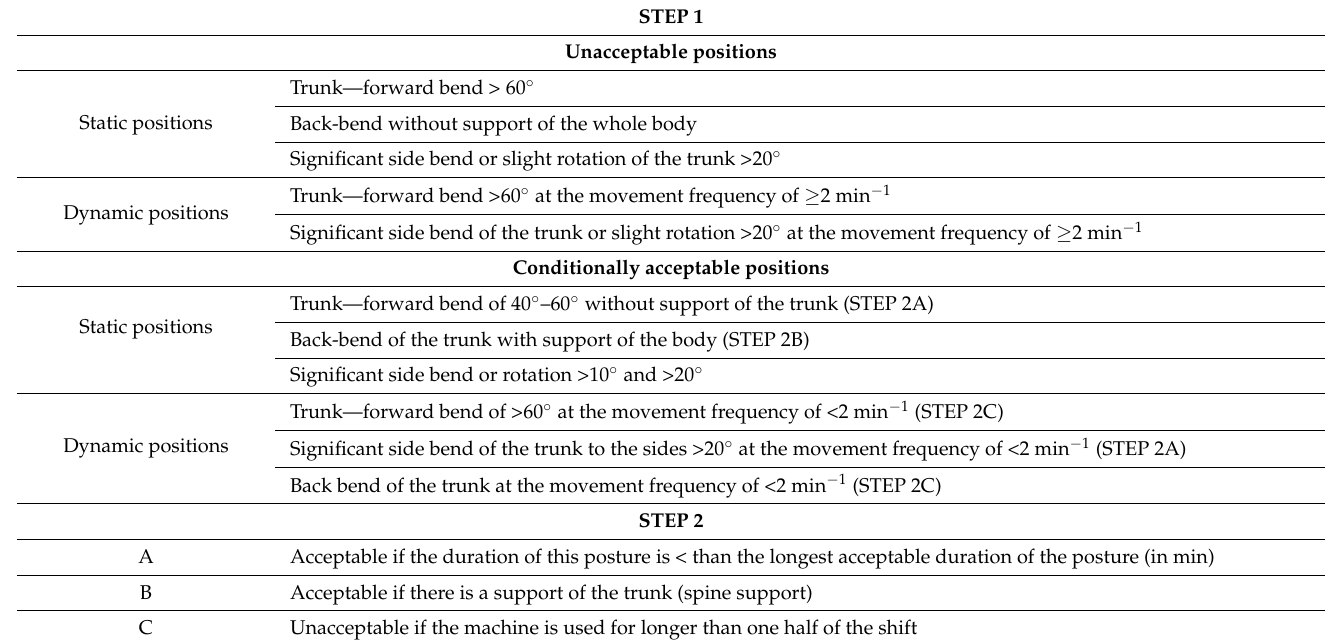
Table 5. Trunk positions [9].